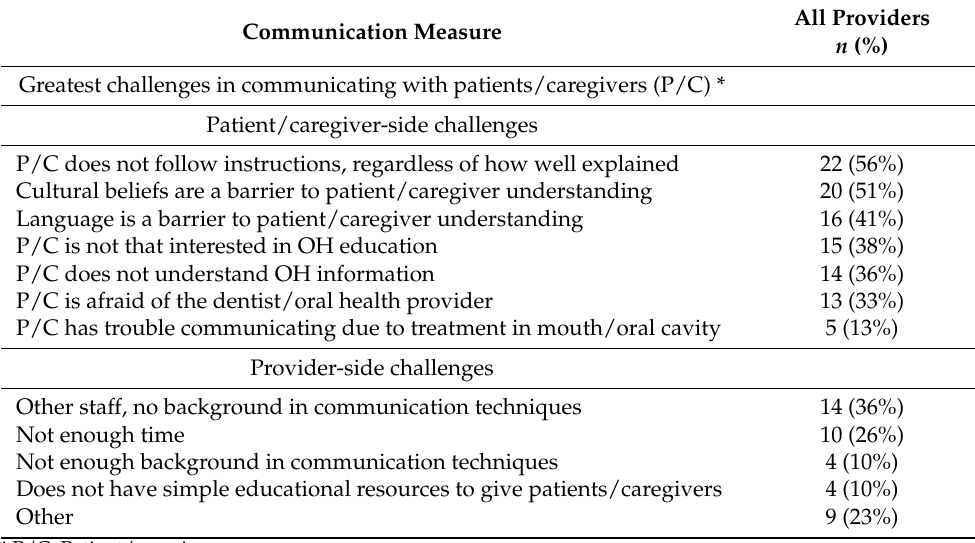
Table 3. Communication challenges for providers: patient/caregiver-side challenges and provider- side challenges ( n =